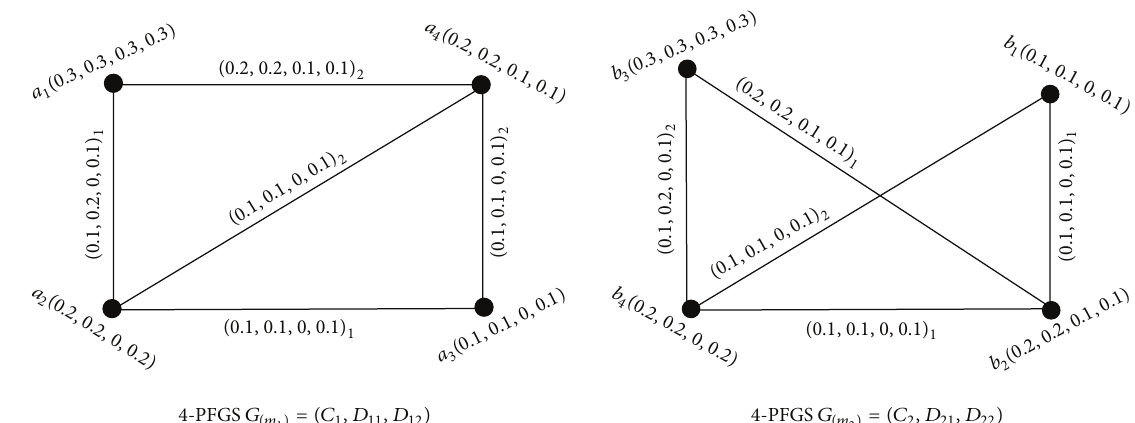
Figure 6: Two isomorphic 4-polar fuzzy graph